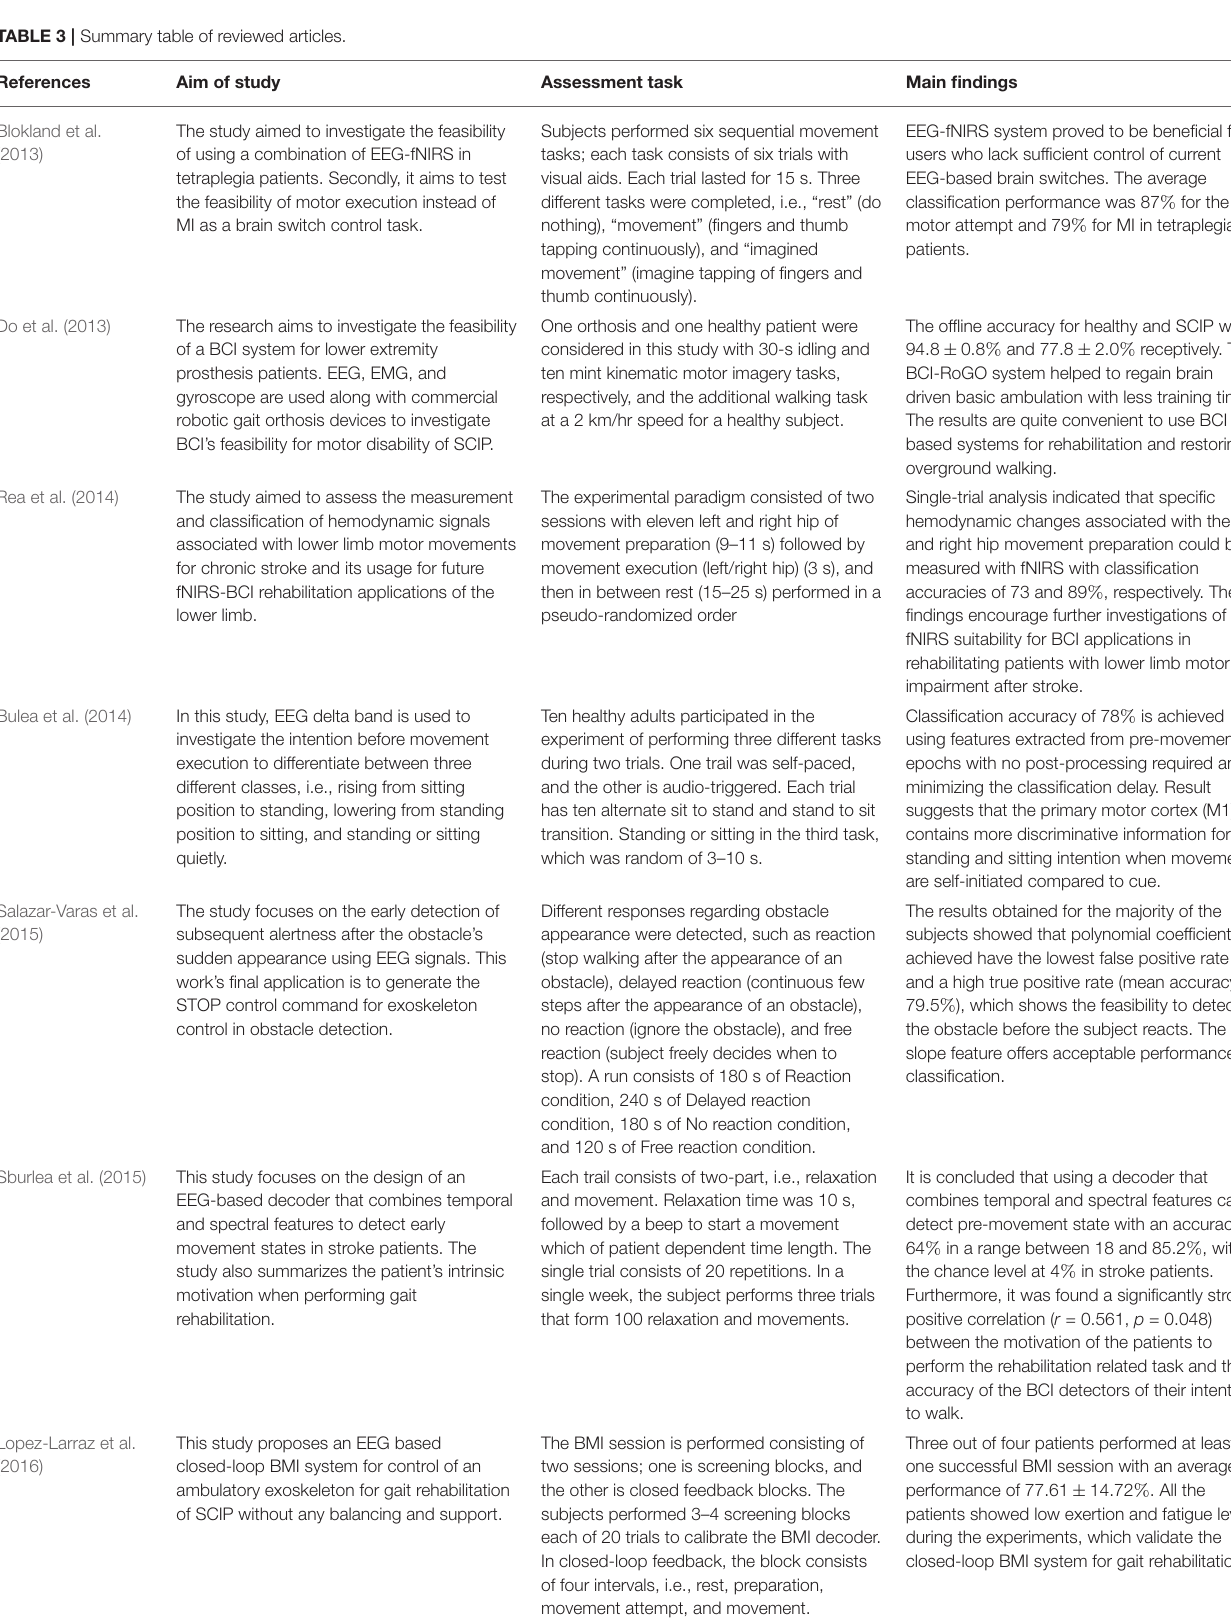
TABLE 3 | Summary table of reviewed